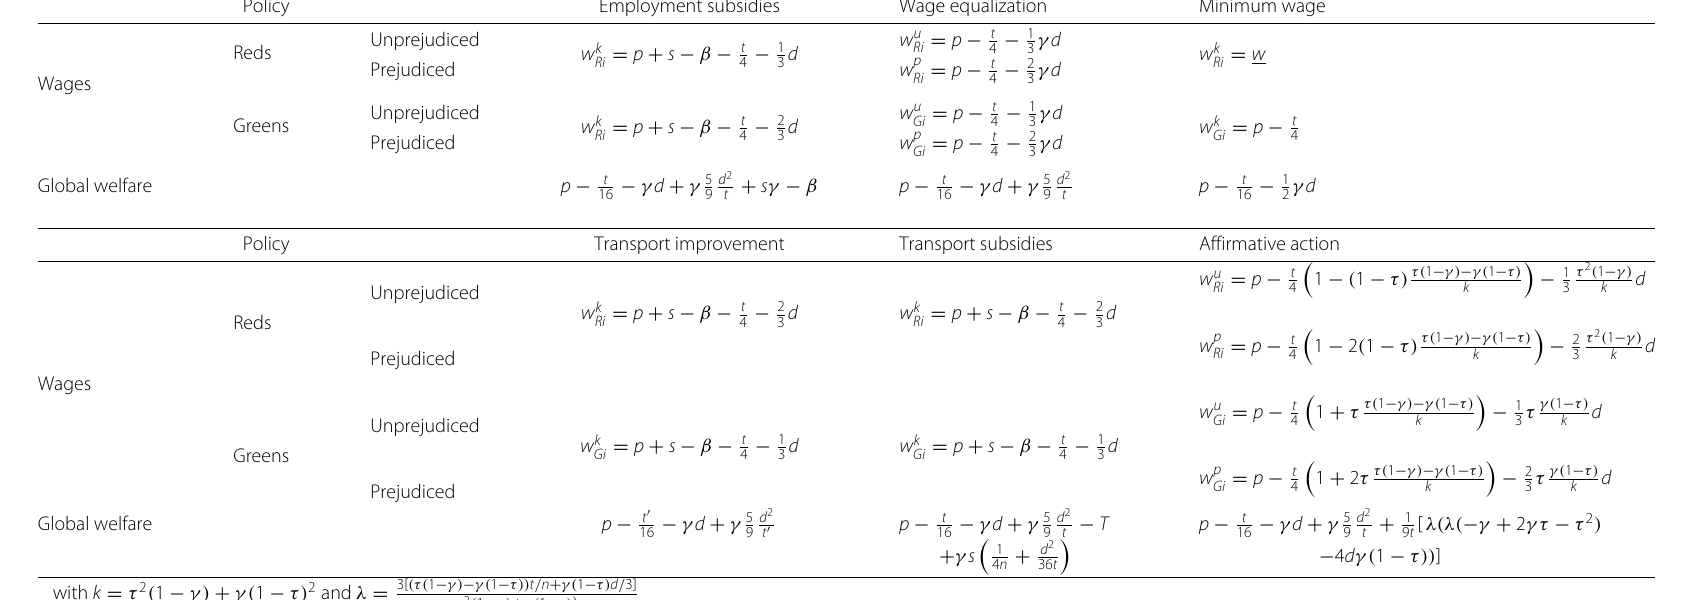
Table 1 Impact of reforms in the case of a four-firm market–firms